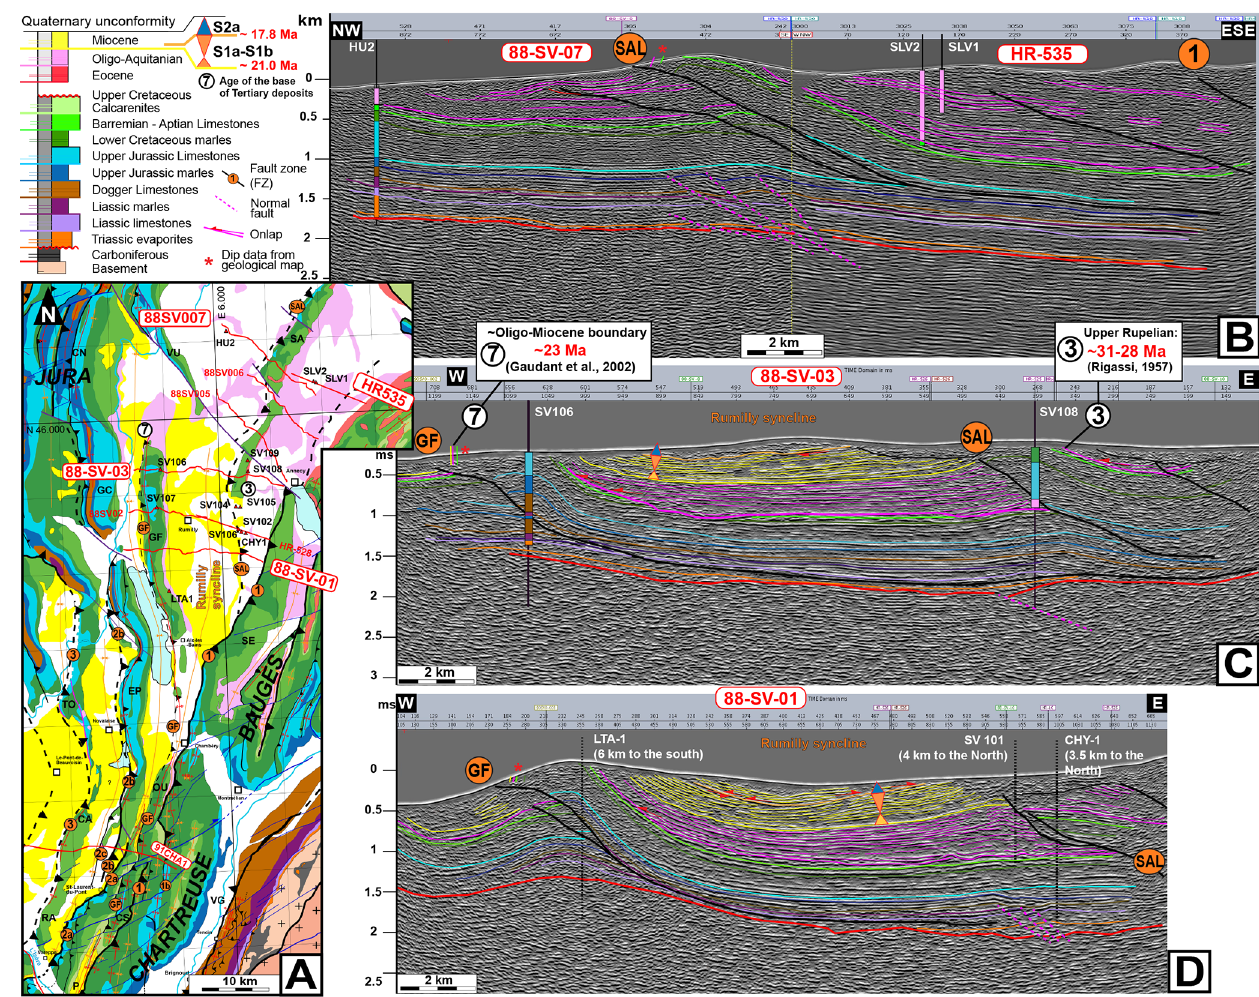
Figure 10. The Salève (SAL) and Gros Foug (GF) faults between the Chartreuse massif and the Jura synclines ( A , legend in Fig. 1) as based on seismic profiles 88SV07 + HR-535 (B) , 88SV03 (C) , and 88SV01 (D)